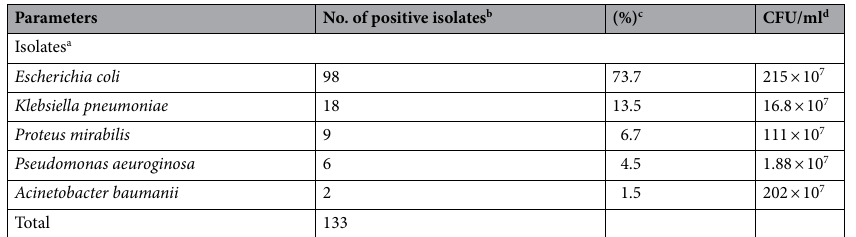
Table 1. Incidence of isolated uropathogenic bacteria in urine samples. Total number of examined urine samples was 170 sample, they were 110 sample from females and 60 samples from male. Number of positive samples was 133 samples comprised from 101 sample from females and 32 sample from males. a Different isolated uropathogens from urine samples. b Number of positive isolates from total number of positive samples. c Percentage of positive isolates from total number of positive samples. d Colony forming unit per ml for each isolated